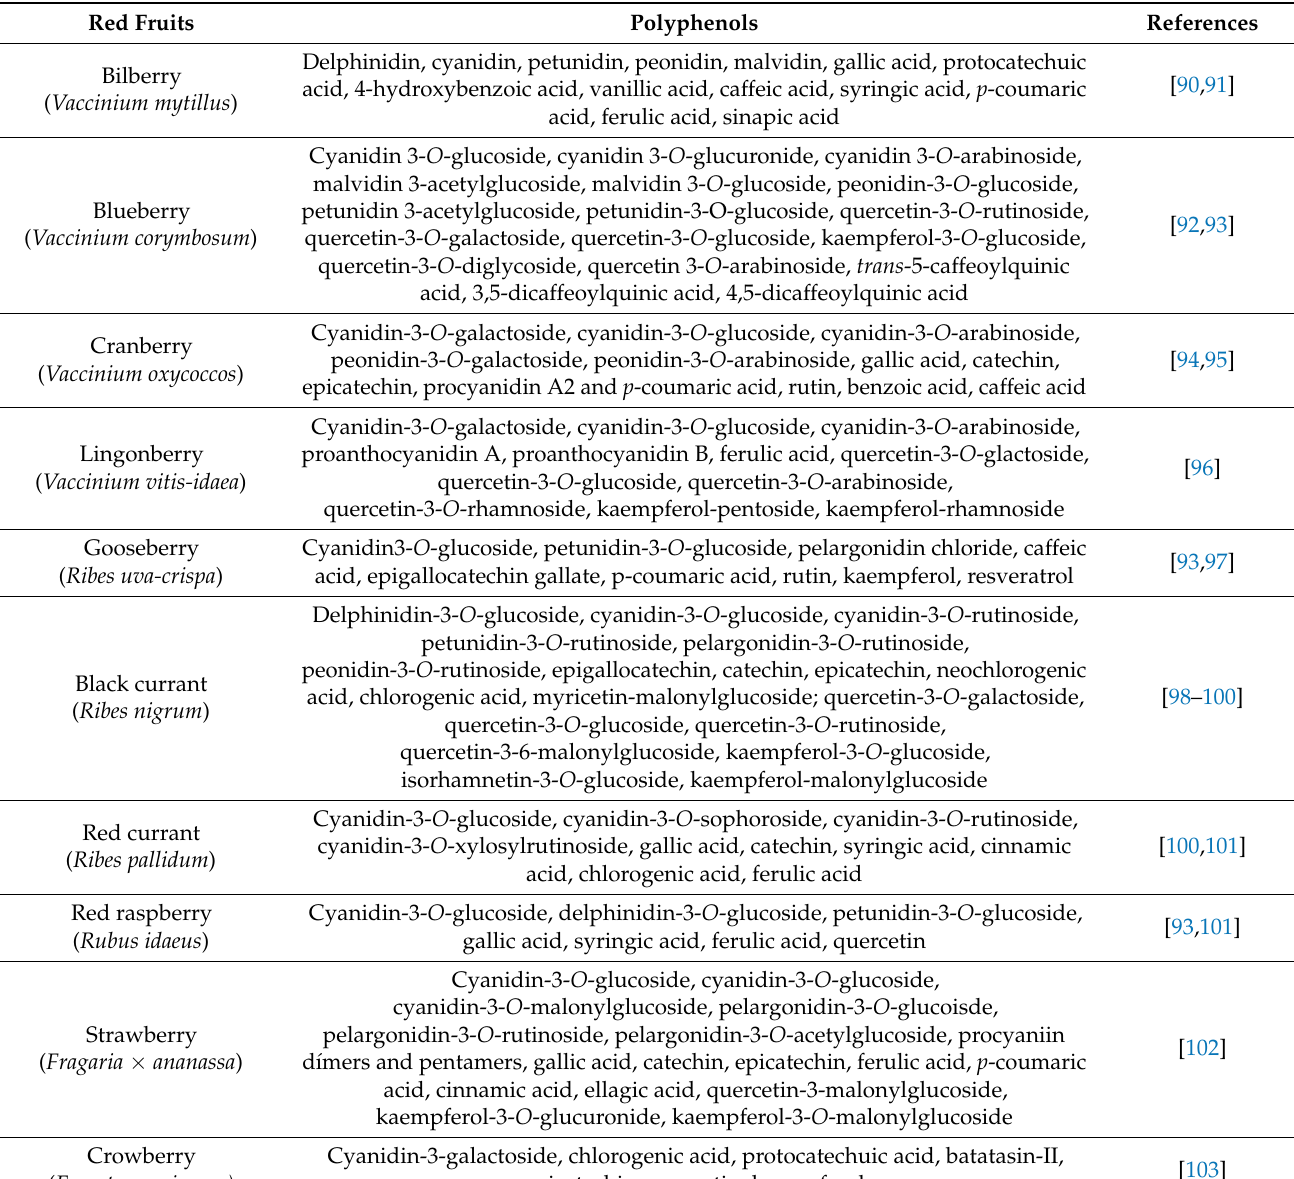
Table 7. Some examples of main polyphenols are found in different types of red